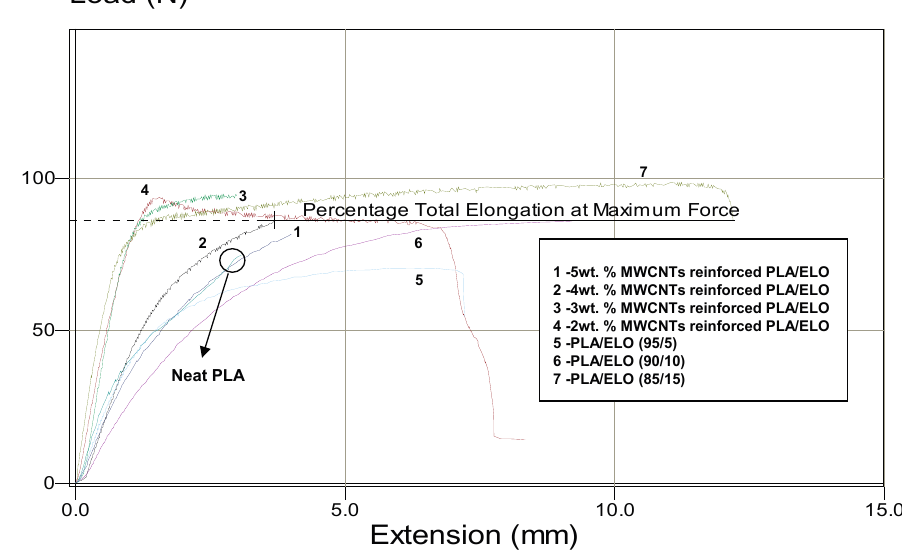
Figure 5. Load-Extension curves for Neat PLA, ELO plasticized PLA, and MWCNTs reinforced ELO plasticized PLA